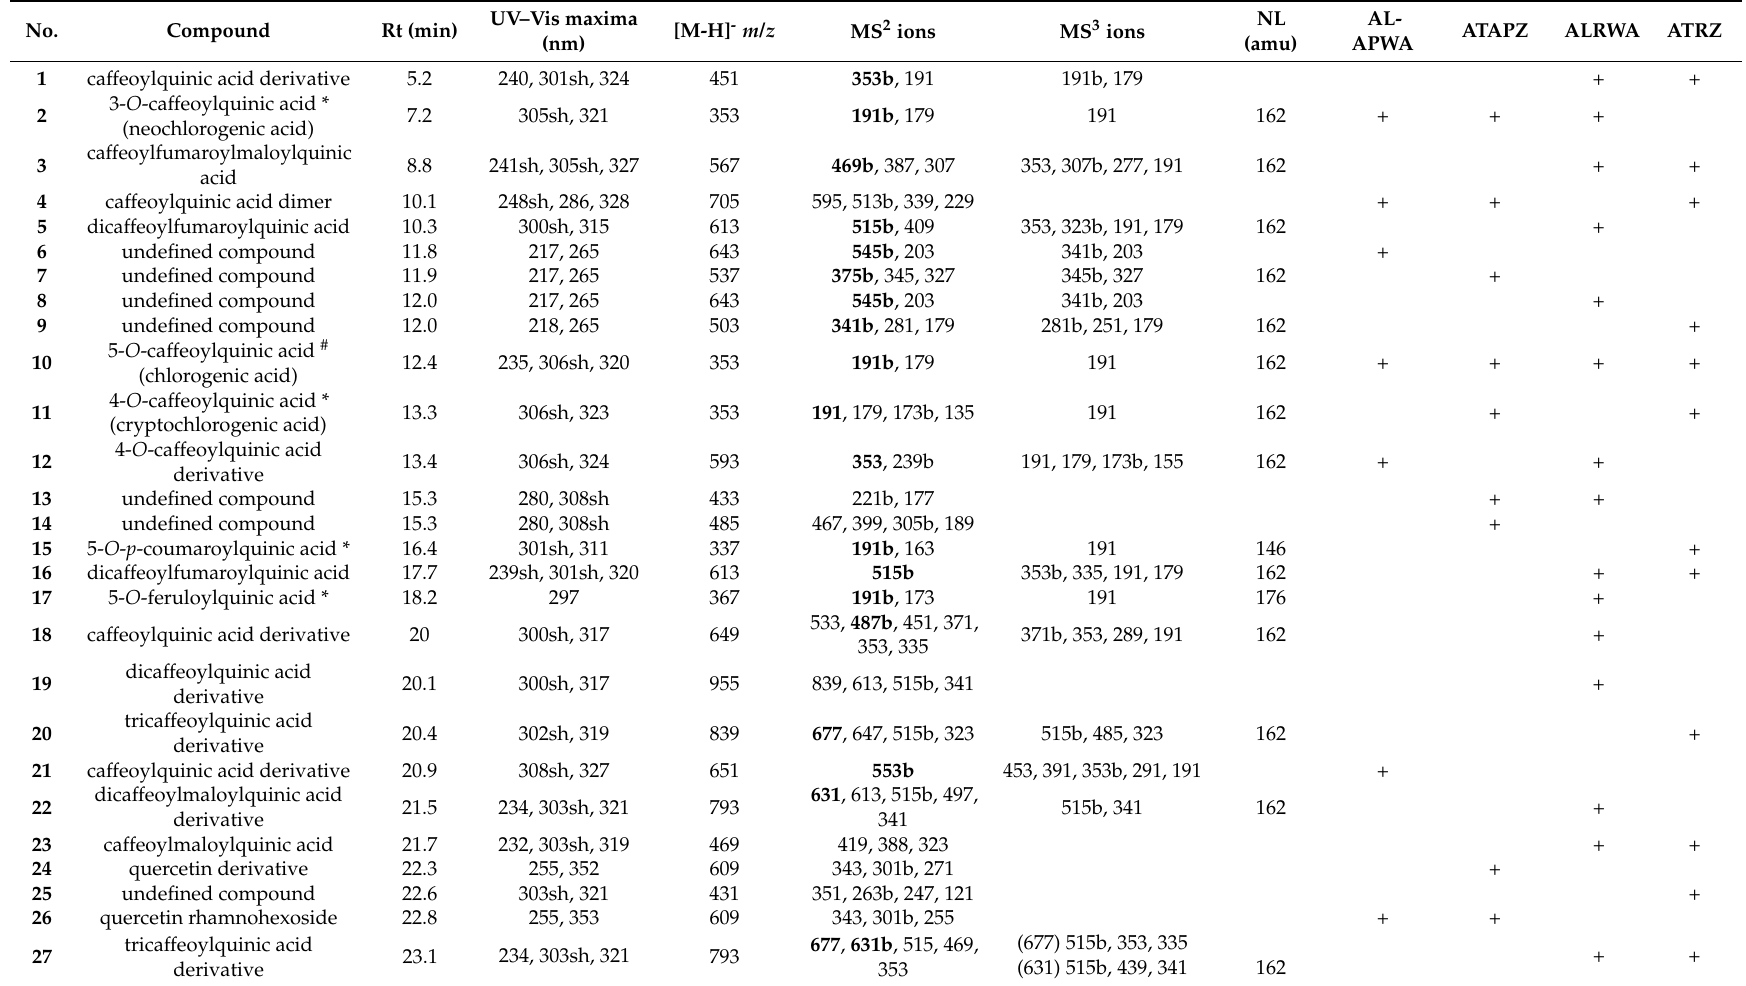
Table 3. UV–Vis and MS data of major compounds found in aerial parts and in roots of Arctium lappa and Arctium